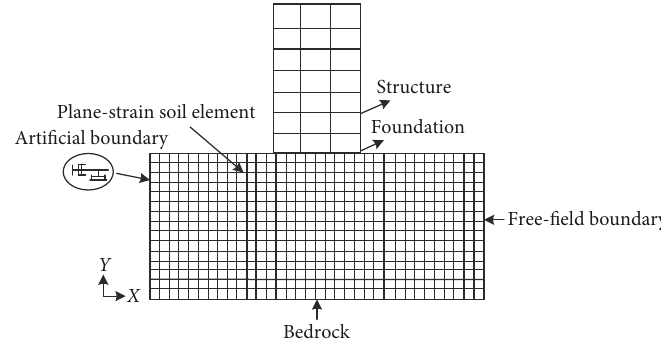
Figure 3: The finite element model of SSI system in OpenSees.